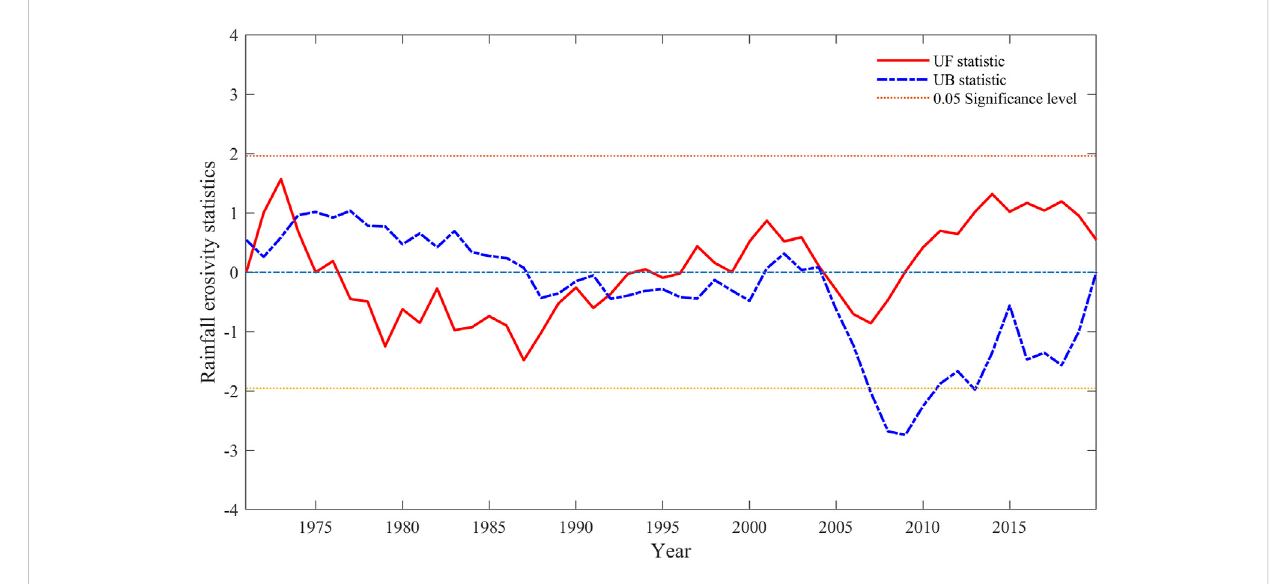
Mann-Kendall abrupt analysis of annual rainfall erosivity.